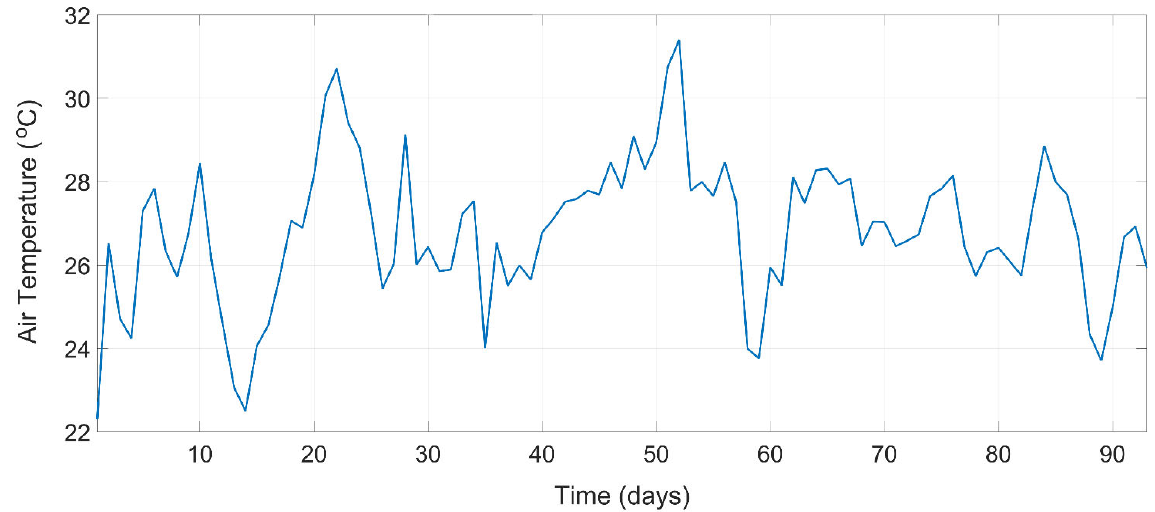
Figure 8. Air temperature readings during the experiment.